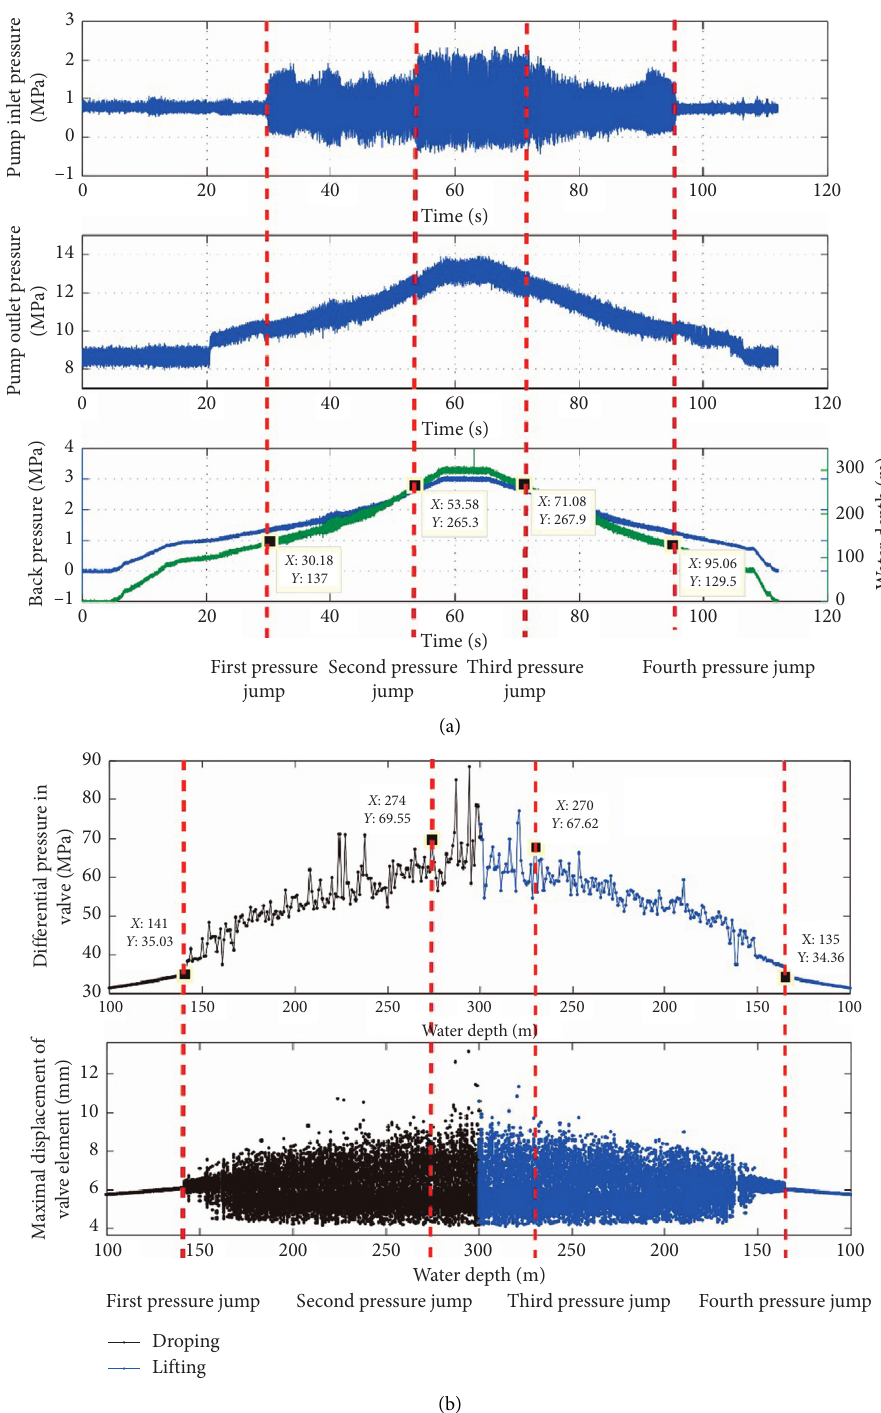
Figure 2: Experimental signal (a) and numerical simulation (b) for the case with inlet pressure